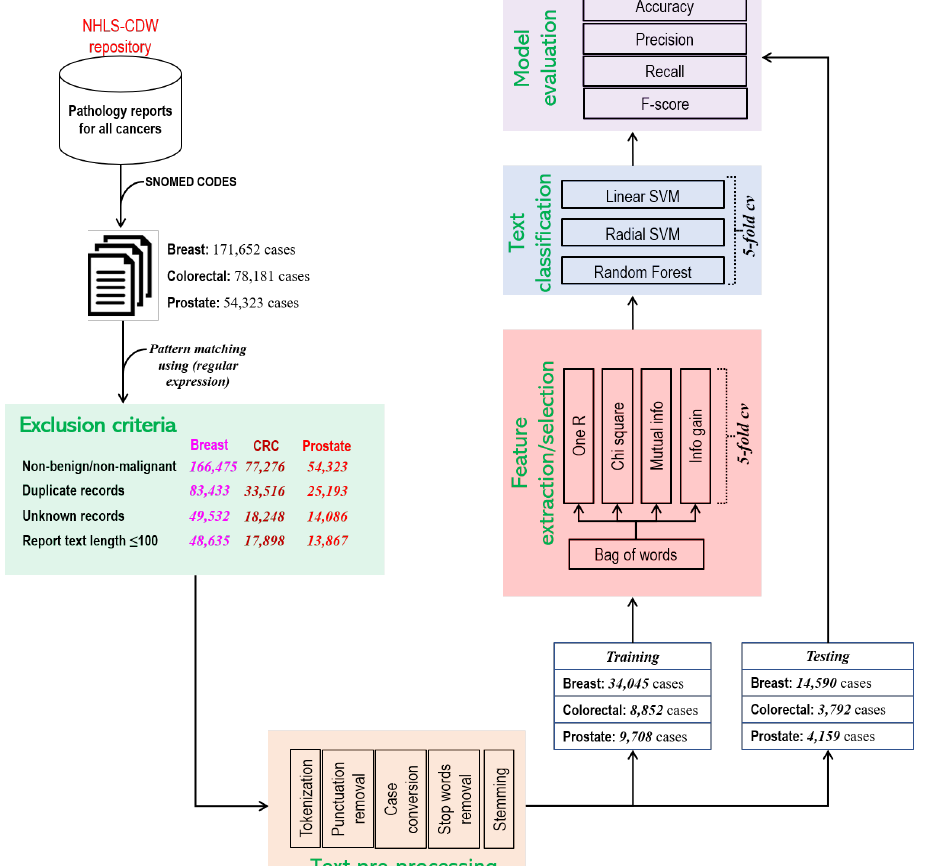
Figure 1. An overall workflow for this study, illustrating the inclusion and exclusion criteria used to extract the final study data and also the modelling approach used in data